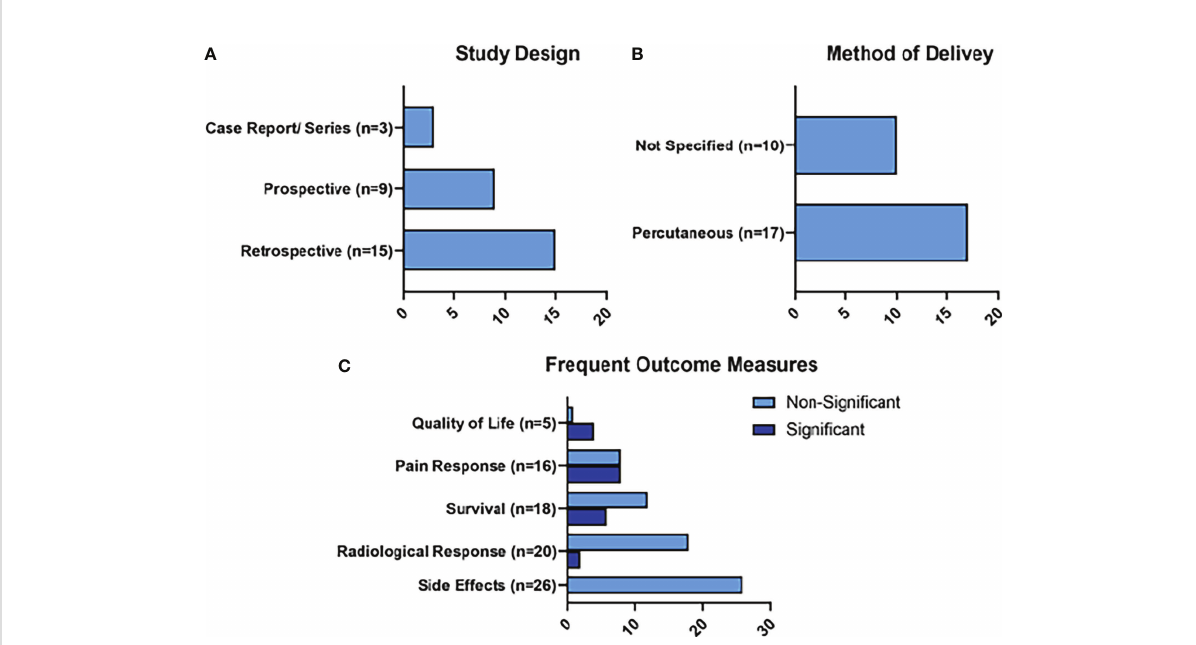
FIGURE 5 Summary of HIFU Results. Figure 5 represents the main characteristics of the HIFU studies included in this review in terms of study design (A) , method of delivery of HIFU (B) , and frequent outcome measures (C) . Frequent outcome measures are subdivided into those that reached statistical signi fi cance, and those that did